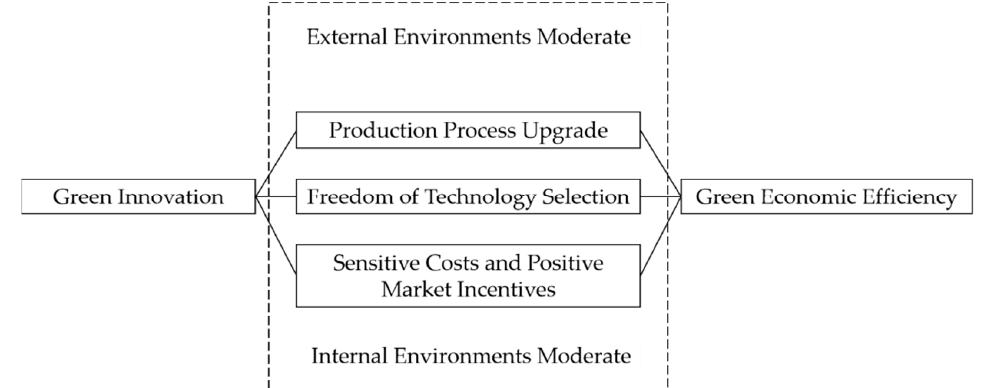
Figure 1. Theoretical logic diagram.